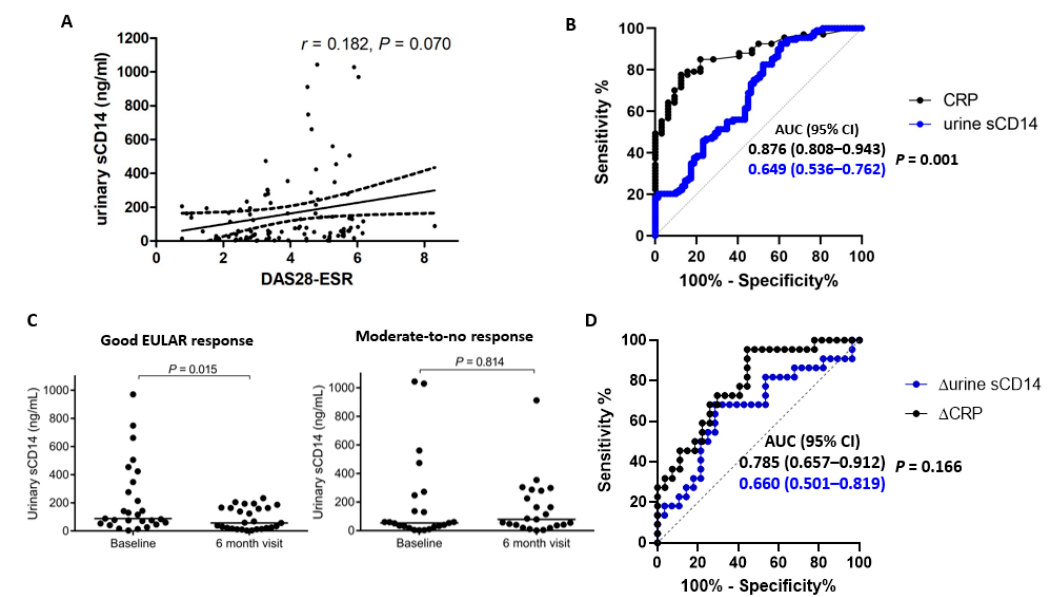
Figure A1. Patients in the CIRAD cohort. Patients were selected from the Center for Integrative Rheumatoid Transcriptomics and Dynamics (CIRAD) cohort. Enrollment in the cohort took place from 2015 and collection of follow-up data is still ongoing. This research and development progressed in stages. In the first stage, validation of sCD14 concentration using the FREND™ system was performed using urine samples, which were collected from 2016 to 2017. In the second stage, validation was performed using serum samples collected from 2017 to 2018.